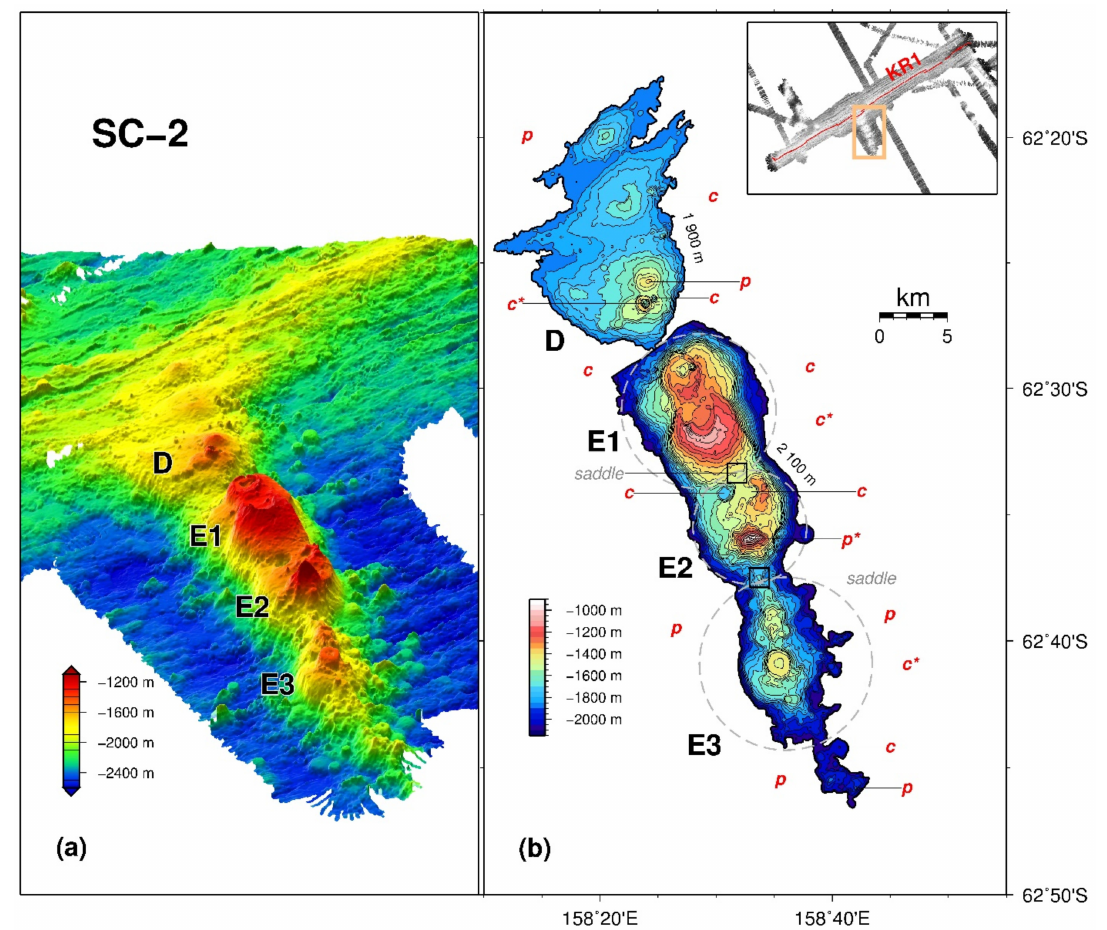
Figure 3. ( a ) 3-D perspective plot with 5x vertical exaggeration for seamount chain SC-2, which stretches to the southeast from the KR1 axis; ( b ) the morphological structures of seamounts D and E (=E1 + E2 + E3) from the reference depth (i.e., 1900 m for seamount D and 2100 m for E)—the bathymetric contour interval is 50 m. Summit types for each seamount are marked with red letters: c = crater/caldera; p = peak; f = flat top. Letters with asterisks indicate the representative summit for each